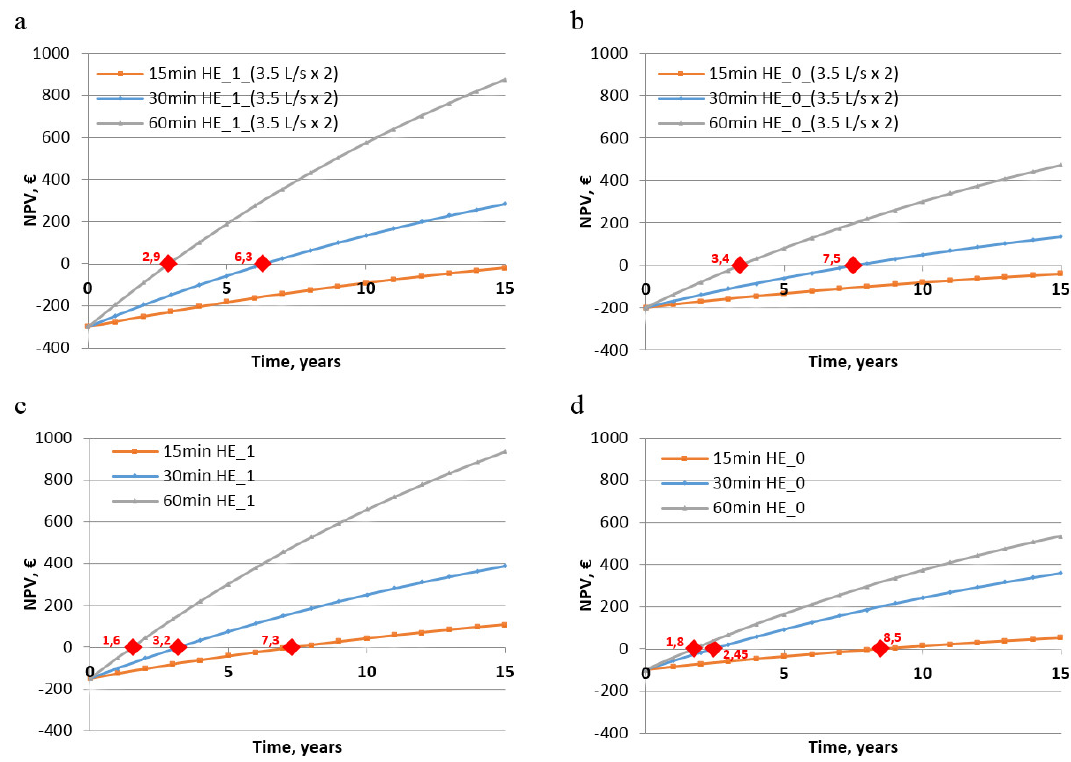
Figure 9. NPV values for Scenario B (261 days): ( a ) HE_1, Variant II; ( b ) HE_0, Variant II; ( c ) HE_1, Variant I; ( d ) HE_0, Variant I.